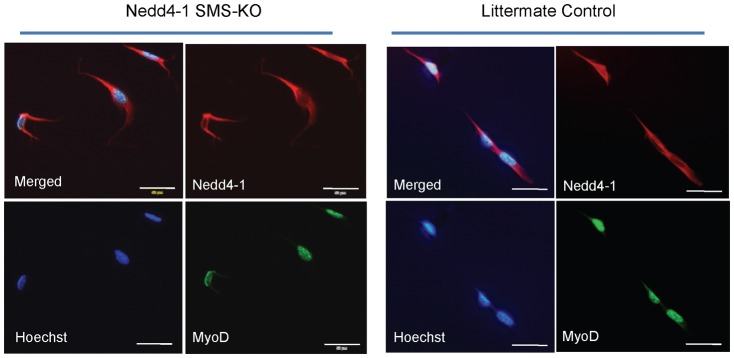
Satellite cells/myoblasts isolated from Nedd4-1 SMS-KO mice express Nedd4-1.Muscle satellite cells/myoblasts were isolated from Nedd4-1 SMS-KO mice and littermate MyoCre;Nedd4-1+/+ control mice and maintained in culture. Cultures were immunostained for Nedd4-1 (red) and MyoD (green) and nuclei were visualized with Hoechst (blue). MyoD, a specific marker of myoblasts, is expressed in nuclei; Nedd4-1 is predominantly cytoplasmic. Myoblasts derived from both Nedd4-1 SMS-KO and littermate control mice demonstrate co-expression of MyoD and Nedd4-1. Immunostaining with 2° antibodies alone served as a negative control and did not demonstrate non-specific staining (data not shown). Scale bar shown = 50 µm.